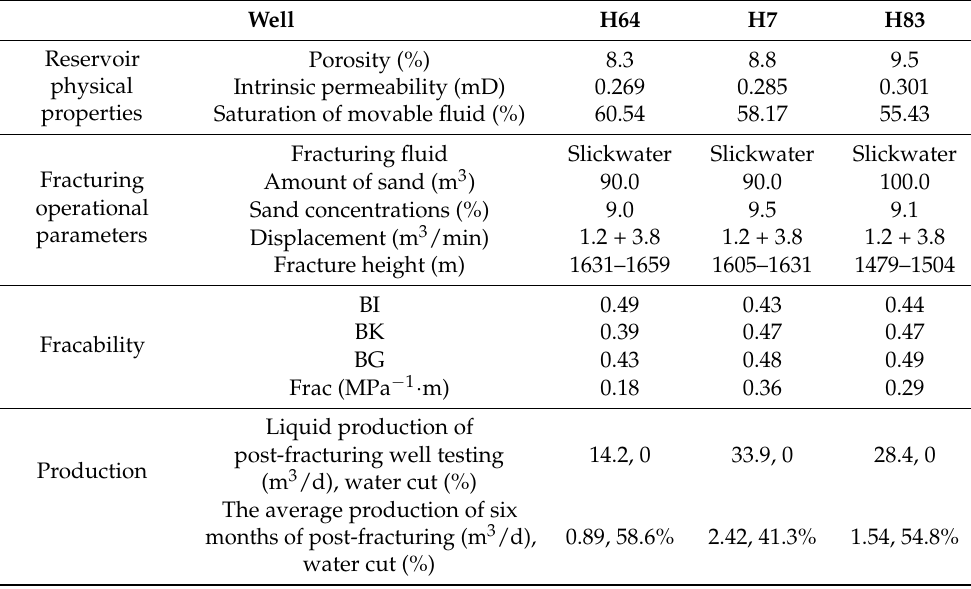
Table 1. Comparison of reservoir physical properties, fracturing process, and production results of three wells in Chang 6 pay